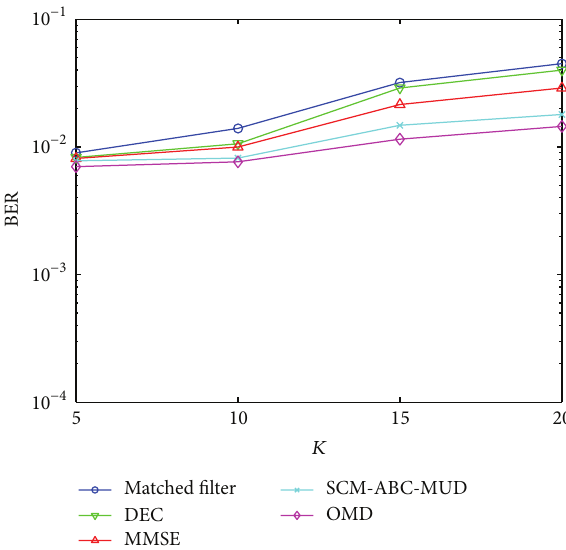
Figure 3: BER performance versus SNR.